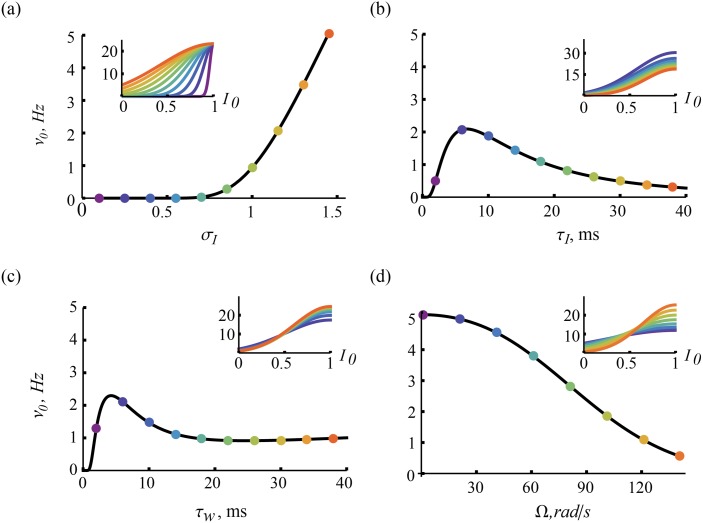
Effect of model parameters on the fluctuation-driven stationary response.The stationary firing rate, Eq (18) for I
0 ∼ 0 (a) increases monotonically with the strength of input fluctuations and (d) decreases monotonically with the intrinsic frequency. Across each of τI and τw ((b) and (c) respectively), the rate exhibits a maximum. Insets are the mean input dependent expression for the stationary response, Eq (17), valid in the regime I
0 ≪ 1. Inset color refers to the value of the parameter (σ
I, τI, τw and Ω) at the location of the colored dots in the main plots. Parameters were otherwise set to their default values.